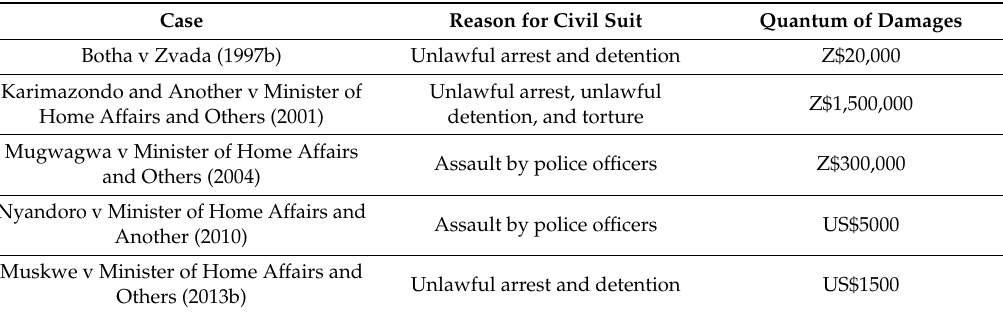
Table 3. The civil suits and quantum of damages and costs.